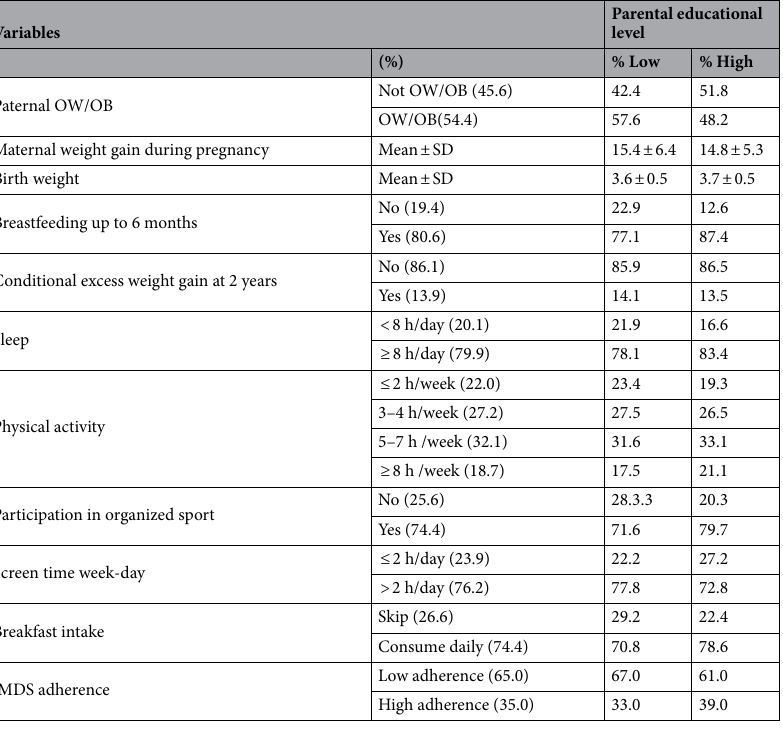
Table 1. Characteristics of study participants at 2 years (n = 59,597), 5 years (n = 27,134), 8 years (n = 28,285) and 14 years (n = 11,278) by parental level of education, the MoBa study. The sample size varies between some variables due to missing data: the potential confounders for all age points were listed at 2 years. fMDS adherence to a Mediterranean-like diet estimated using a food frequency-based Mediterranean Diet Score.